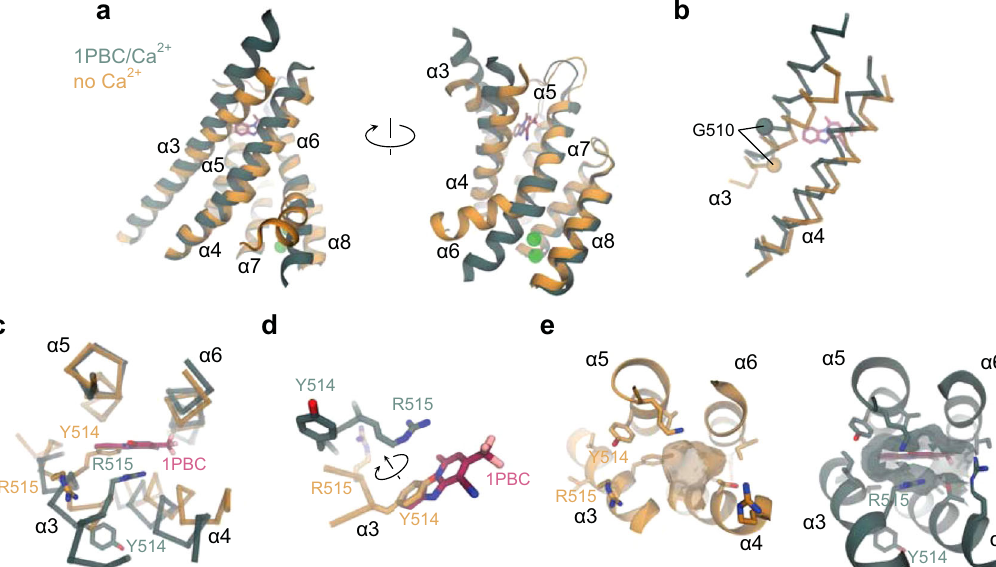
Fig. 6 Rearrangement of the extracellular vestibule. a Superposition of the pore region of the rebuilt Ca 2 + -free apo (PDB: 5OYG) and the 1PBC/Ca 2 + -bound structures viewed from within the membrane. b α 3 and α 4 of the superposed structures in C α representation. The C α atoms of Gly 510 are shown as spheres. c α 3 and α 4 with respect to the other pore-forming helices in the superposed structures viewed from the extracellular side. Selected residues on α 3 are displayed. d Close-up view of the residues that rearrange upon the binding of 1PBC. e Molecularsurface of the extracellular vestibuleviewed from the top of the membrane. Selected residues lining the volume are shown. a – e The 1PBC/Ca 2 + structure is shown in green and the Ca 2 + -free apo structure in gold.